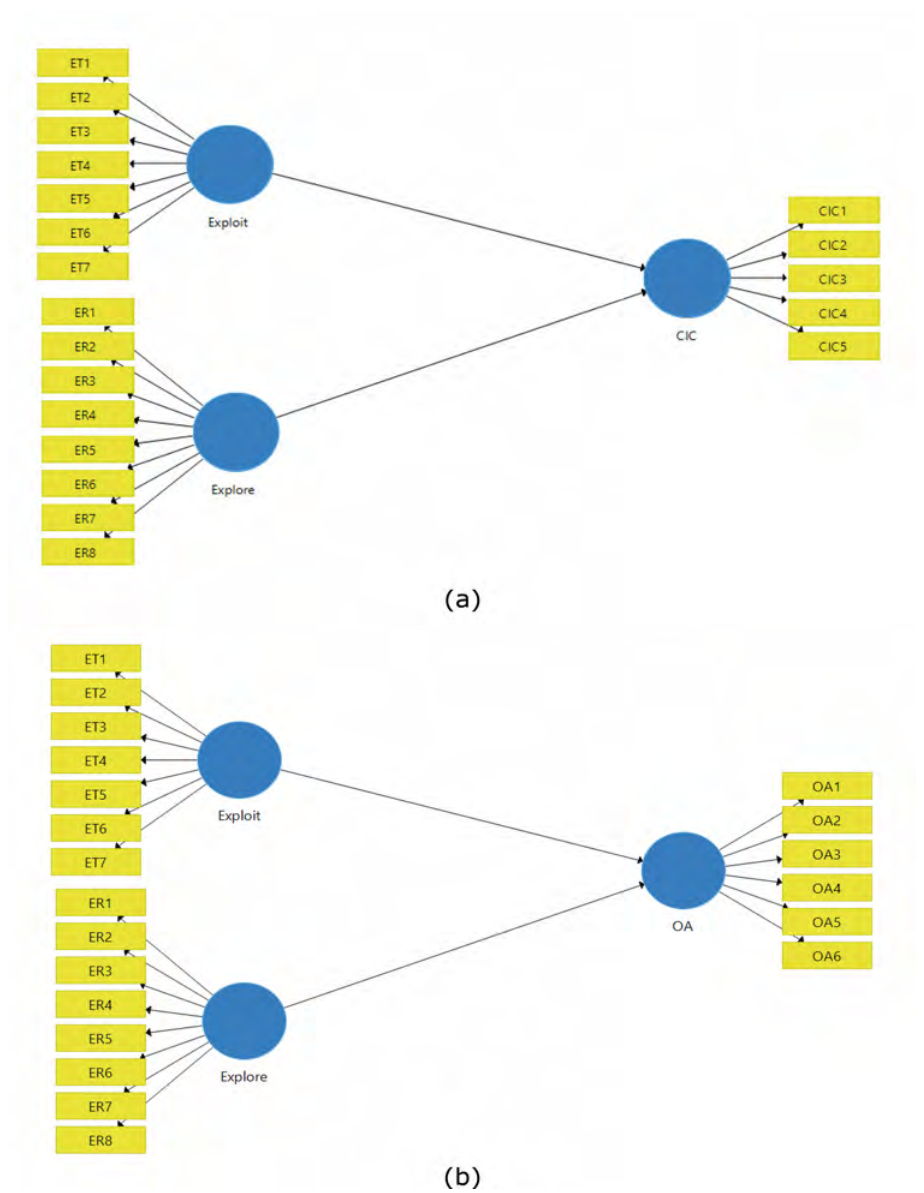
Figure 4. The links from exploring and exploiting capabilities to (a) continuous improvement capability (CIC) and (b) organizational agility (OA)